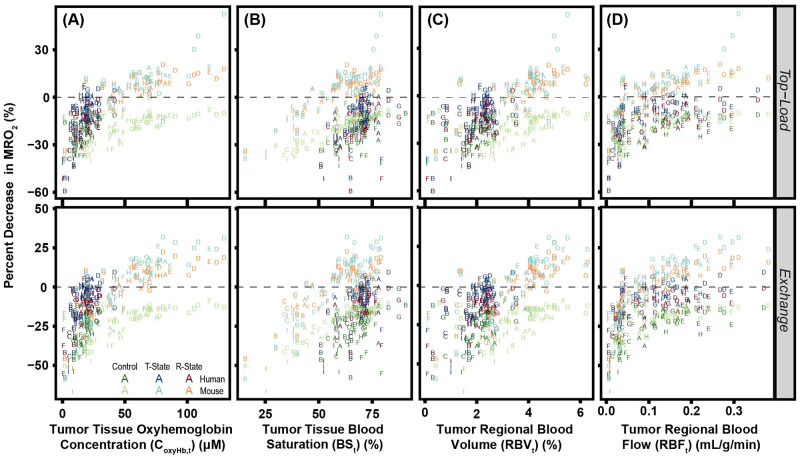
The effect tumor (A) oxyHb concentration, (B) tissue blood saturation, (C) RBV, and (D)RBF on the percent changes in MRO2.The baseline (unsupplemented) condition is depicted as the dashed line at zero. Letters labeling each data point indicate the vessel bed configuration for that artificial tumor construct.